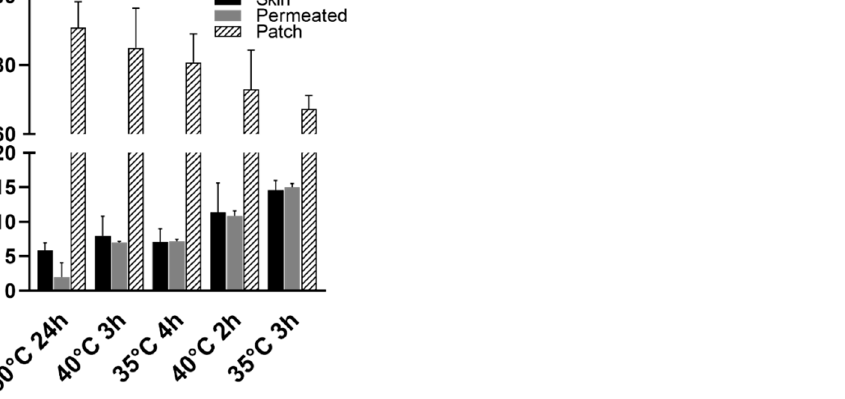
Figure 6. Distribution of E2 after 28 h permeation experiments in skin and patch and through permeation into the acceptor compartment of Franz cells.